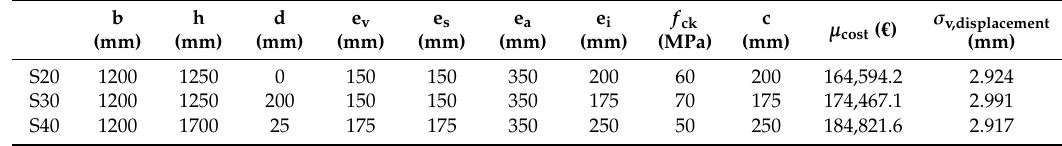
Table 11. Comparison of different designs of the Pareto Frontier with a 20% variation of the prestressing force.